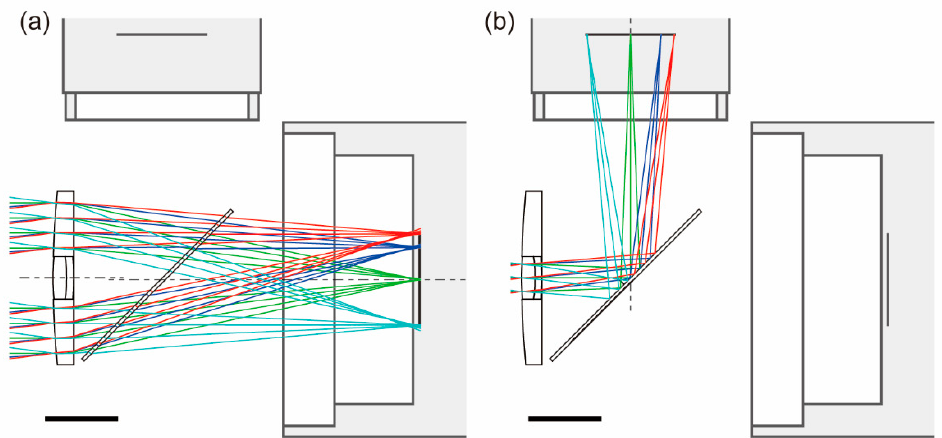
Figure 3. Results of ray-tracing simulation for hybrid silicon–glass lens and silicon beam splitter. ( a ) Long-wavelength infrared (LWIR) light focused using an outer silicon lens. ( b ) Visible light focused using an inner glass lens. The scale bars represent 10 mm.